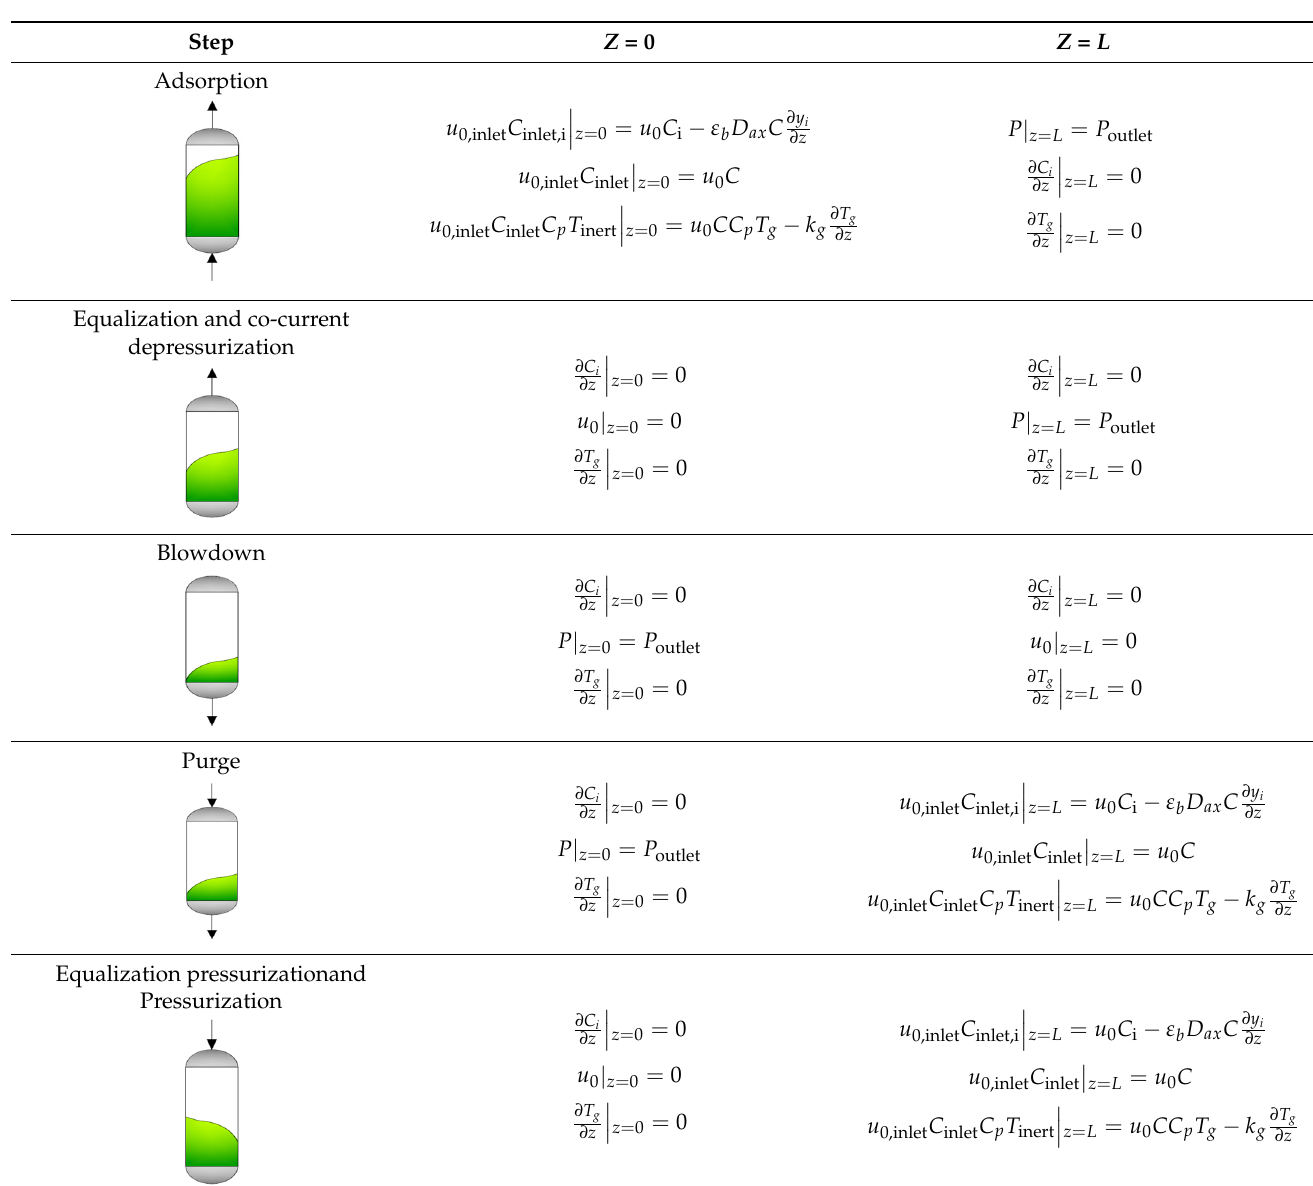
Table 1. Boundary conditions for each step.